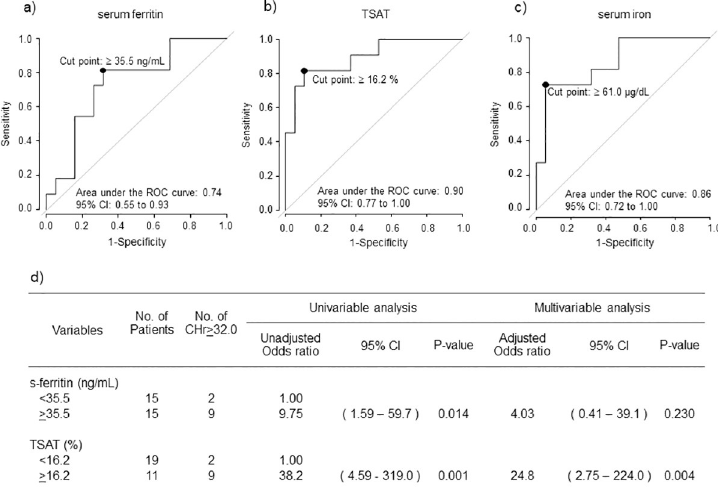
Fig 2. CHr levels and iron status on Day 28. ROC curves of (a) serum ferritin, (b) TSAT and (c) s-Fe for CHr � 32.0 pg on Day 28. The respective cutoff values for s-ft and TSAT were � 35.5 ng/mL (sensitivity 68.4%, specificity 81.8%, AUC 0.74, 95% CI 0.55–0.93), 16.2% (sensitivity 89.5%, specificity 81.8%, AUC 0.90, 95% CI 0.77–1.00) and 61.0 μ g/dL (sensitivity 94.7%, specificity 72.7%, AUC 0.86, 95% CI 0.72–1.00). (d) Logistic model analysis with CHr � 32.0 pg as the